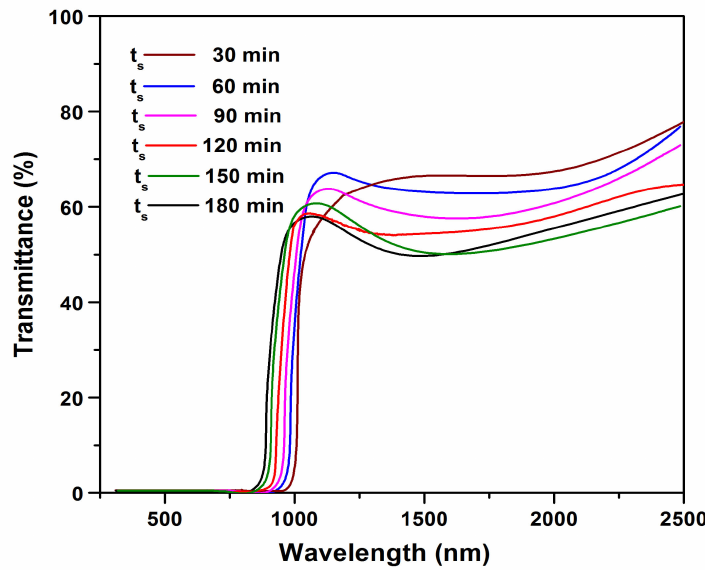
Figure 7. Transmittance versus wavelength spectra of SnS